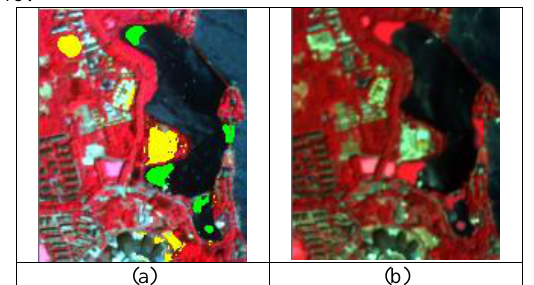
Figure 20. Examples of information provided by the changed detection